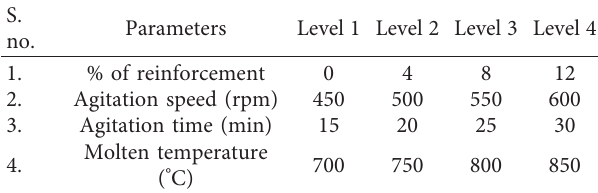
Table 2: Stir-casting process parameters and its levels.